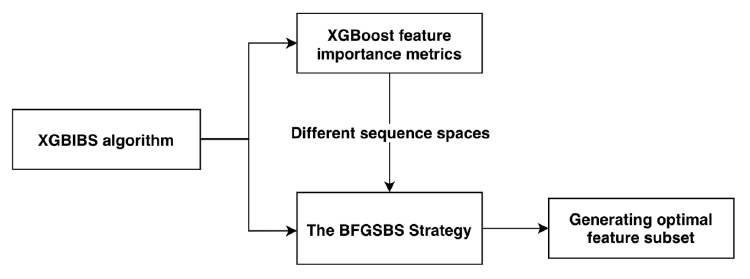
Figure 1. Two elements of the XGBIBS